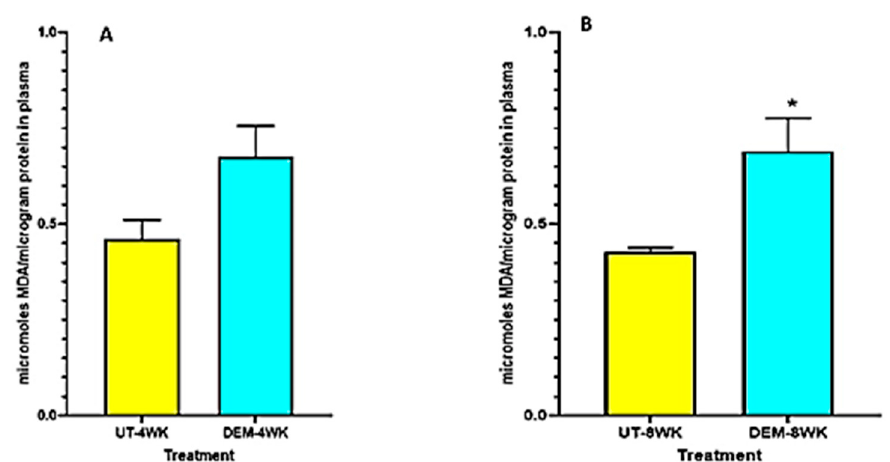
Figure 4. Measurement of MDA in the lung lysates and plasma of M. tb infected mice that were sham-treated or treated with DEM. MDA levels were measured in the plasma at 4 weeks ( A ) and 8 weeks ( B ) post- M. tb infection. Statistical analysis was performed using GraphPad Prism software. Unpaired t tests were performed using Welsch correction. All values reported are representative of the mean values for each respective category and a p -value of <0.05 was considered significant. Any placement of an asterisk (*) denotes a direct comparison of the DEM-treated versus the untreated category. The sample size ( n ) includes six mice each in the untreated and DEM-treated